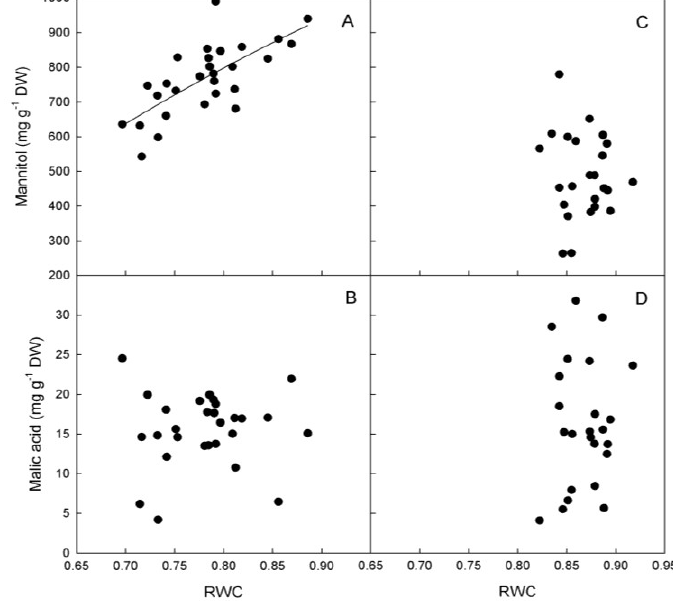
Figure 6. Relationships between mannitol, malic acid, and relative water content (RWC) in leaves of ( a , b ) ‘Biancolilla’ and ( c , d ) ‘Cerasuola’ olive trees during a typical summer day in Sicily. In ‘Biancolilla’, Mannitol = 1066 + 1203 Ln(RWC); R 2 = 0.511, p < 0.001. Models tested by regression analysis and best equation chosen according to Schwarz’s Bayesian Information